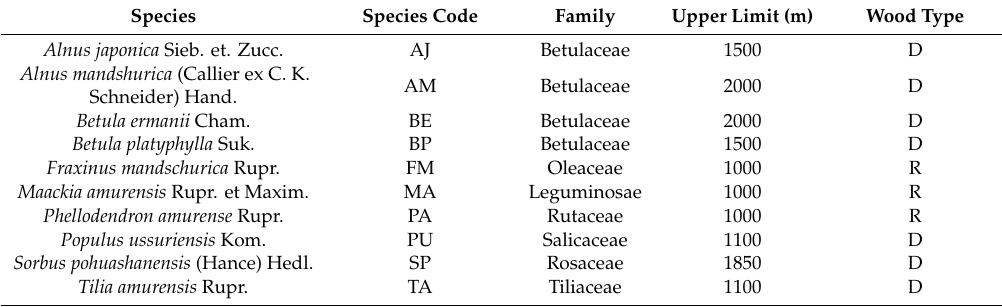
Table 1. Basic information of the 10 tree species examined. ‘D’ and ‘R’ represent di ff use-porous and ring-porous, respectively.